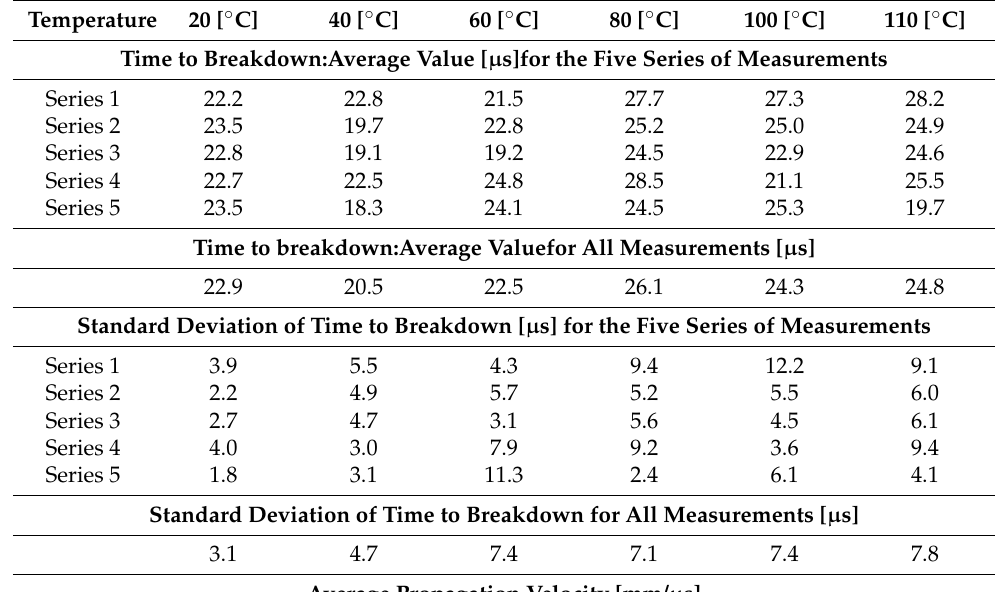
Table 3. Average times to breakdown and standard deviations for five series of measurement at the selected